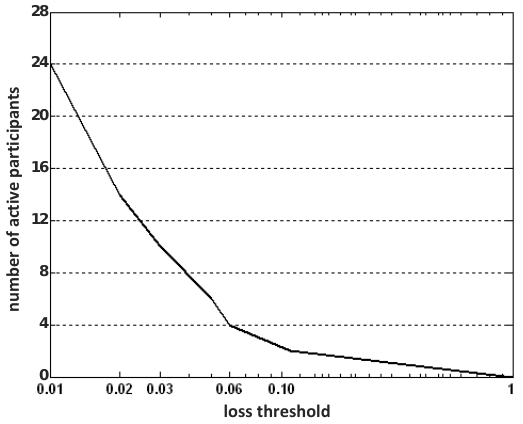
Figure 4. Number of active participants vs. loss threshold.